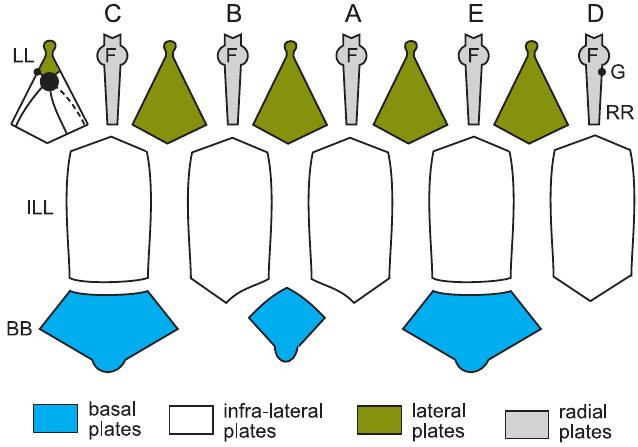
Fig. 13. Thecal plates of the Silurian blastozoan Lysocystites sculptus Miller, 1889, Indiana, USA, showing homologies with blastoids, coro- nates, and glyptocystitoids. A–E, Carpenter’s (1884, 1891) ambulacra. Unknown erect ambulacra arose from facets (F) on ambulacral plates (RR), homologues of blastoid lancet plates and the radial plates of Rhombifera Barrande, 1867 (Fig. 19A 3 ). The mouth frame is composed of five deltoids (LL, homologues of the lateral plates of Rhombifera ). The periproct (P) lies in the CD interambulacrum above additional deltoid plates (white) and shares the gonopore (G). The main body of the cup is formed of five infra- lateral plates (ILL, homologues of blastoid radials) and three basal plates (BB). Compare with the oral view, Fig. 20B. For plate homologies see Table 2. Redrawn from Sprinkle 1973:140, fig.